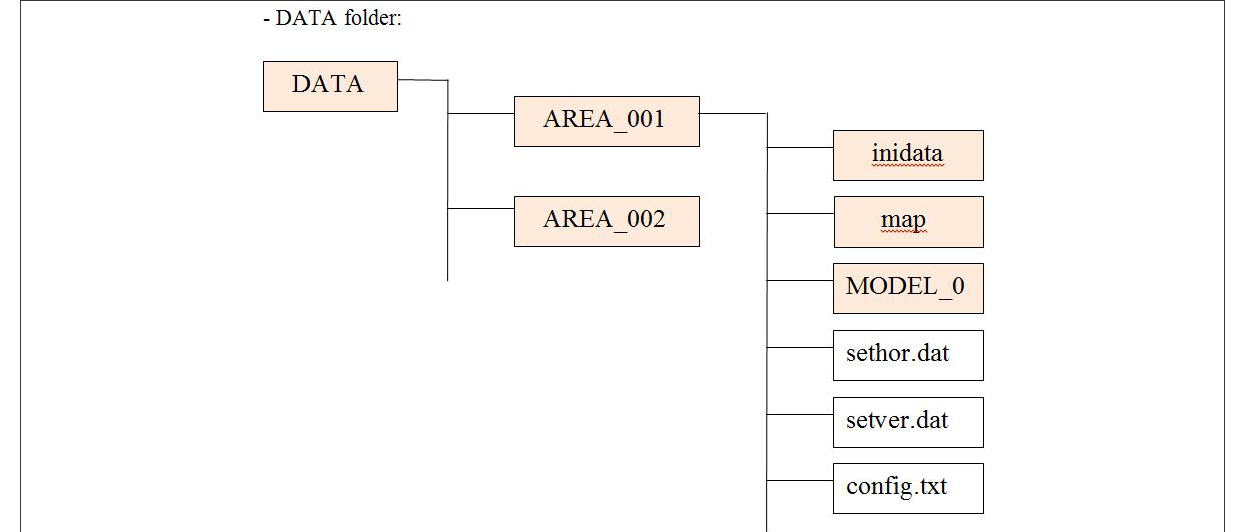
Figure A.1. Root directory structure of PARTOS software. Orange boxes represent folders and white boxes represent files.